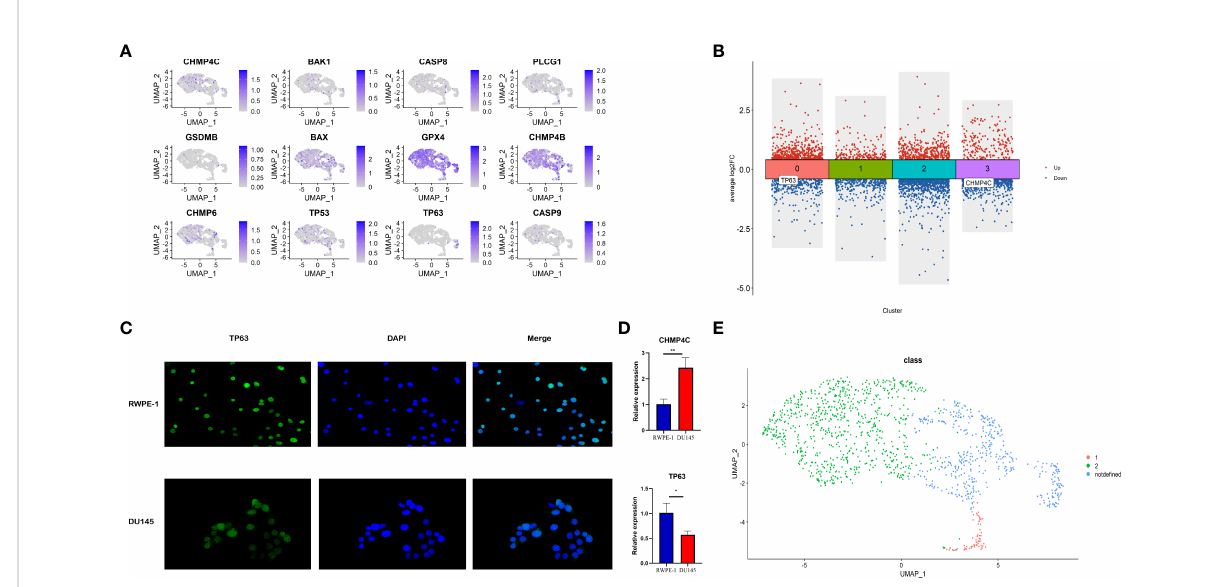
FIGURE 11 Identi fi cation of different pyroptosis patterns at single-cell level according to the expression of class markers (TP63 and CHMP4C). (A) Feature plot shows the expressions of 12 PPGs in malignant epithalial cells. (B) The DEGs of the 4 clusters of malignant epithelial cells. TP63 was down-regulated in cluster0 and CHMP4C was down-regulated in cluster3. (C) The distribution and expression of TP63 in normal prostate cell line RWPE-1 and prostate cancer cell line DU-145. (D) The relative mRNA expression level of CHMP4C and TP63 in normal prostate cell line RWPE-1 and prostate